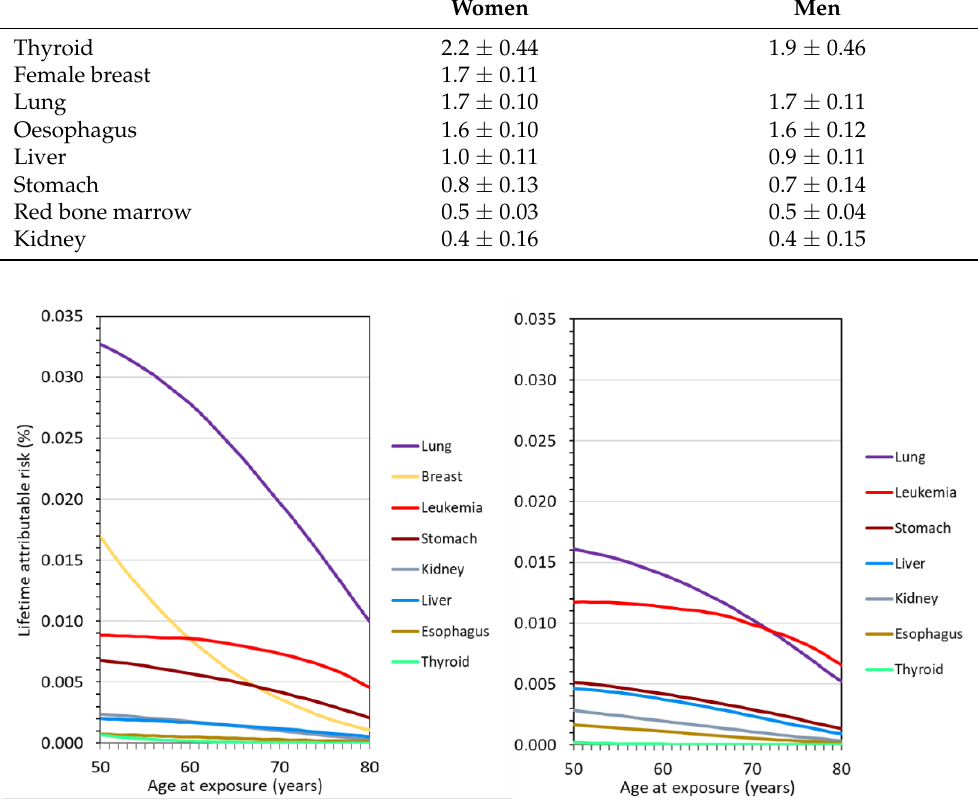
Figure 2. Organ-specific lifetime attributable risks, LAR , (cancer incidence) for women ( left ) and men ( right ) as functions of age at exposure for organ equivalent doses of 10 mSv for the German general population.